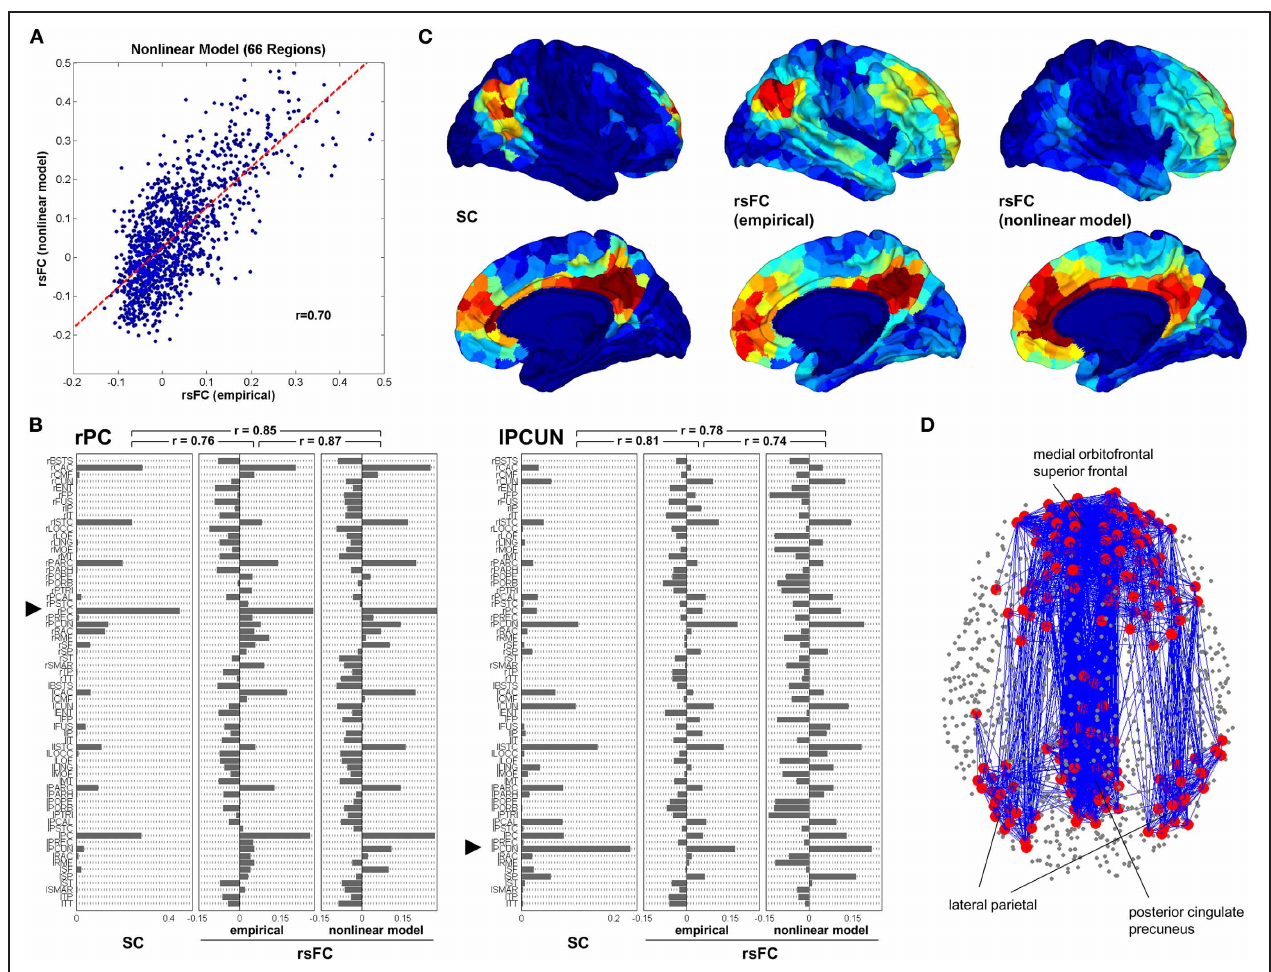
resting state functional connectivity and modeled resting state functional connectivity within the default mode network (DMN). Within the posterior cingulated/precuneus, medial orbitofrontal cortex and lateral parietal cortex in both hemispheres were selected clusters of five ROIs at positions that most closely matched the coordinates of peak foci of the DMN. These 30 ROIs served as the seeds from which SC and rsFC were determined. (D) Structural connectivity within the DMN. Adapted from Honey et al.